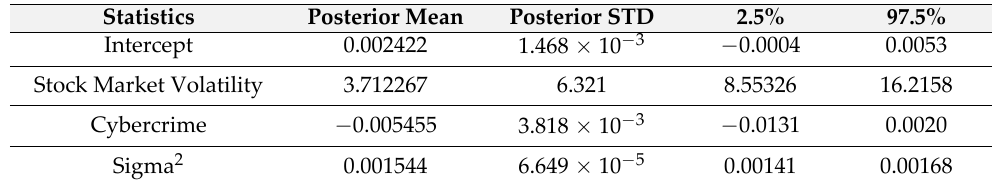
Table 3. BLR results with Return on Bitcoin as dependent variable.